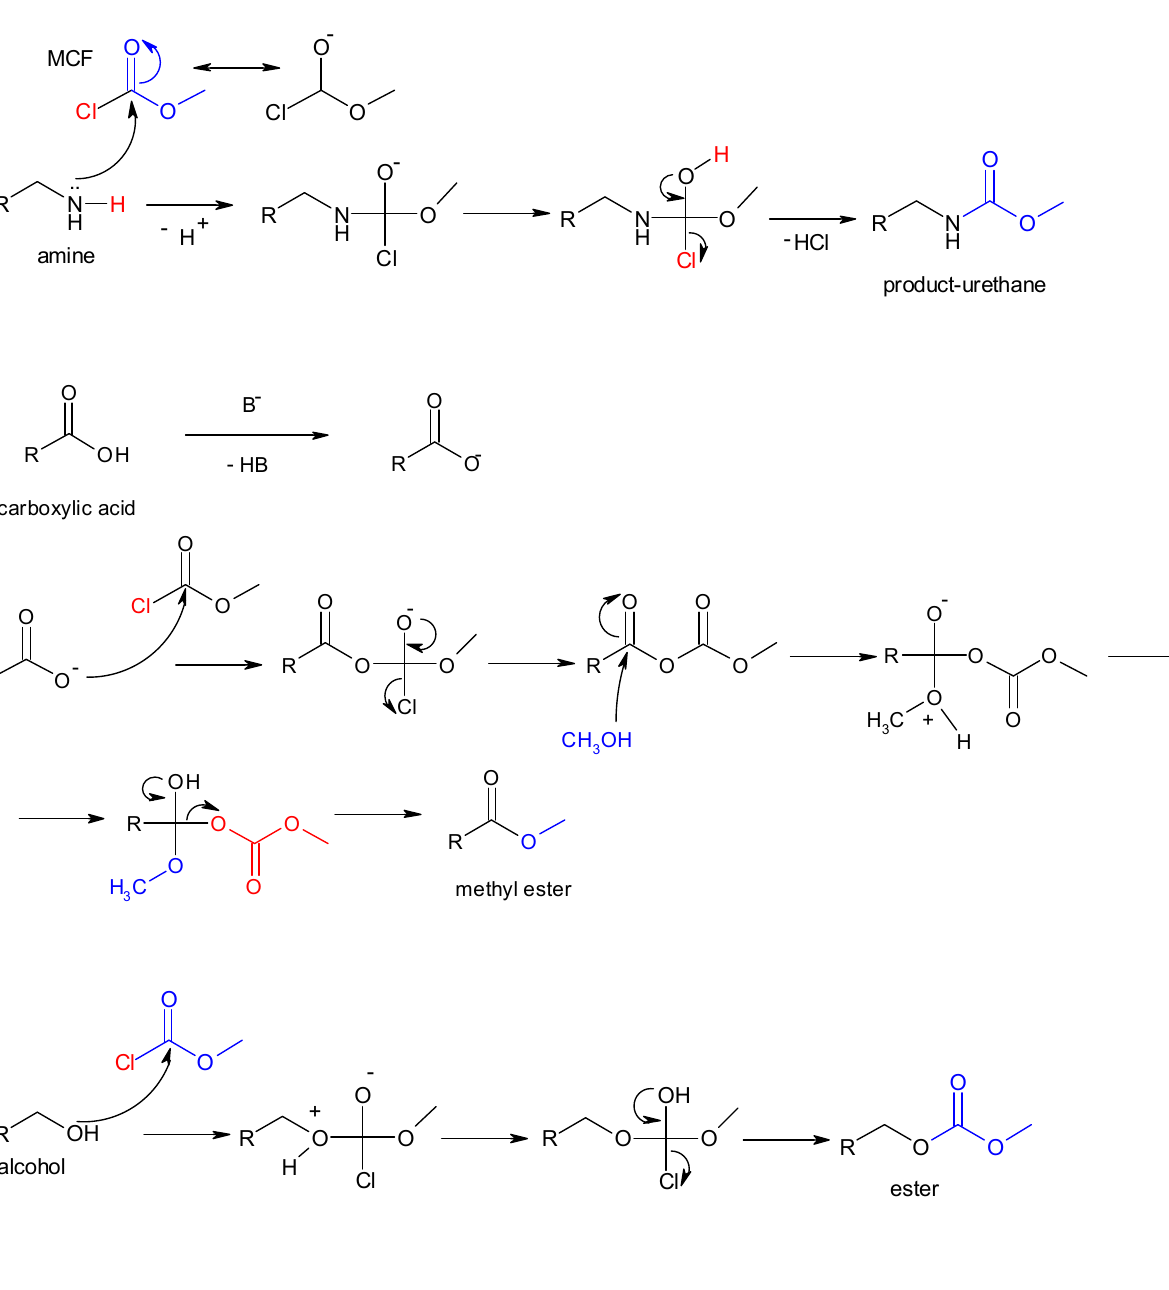
Figure 2. Overall scheme of chemical derivatization of metabolites by alkylation using methyl chloroformate (MCF). Mainly amino and non-amino organic acids are derivatized by this technique, but some amines and alcohols can also be derivatized as shown